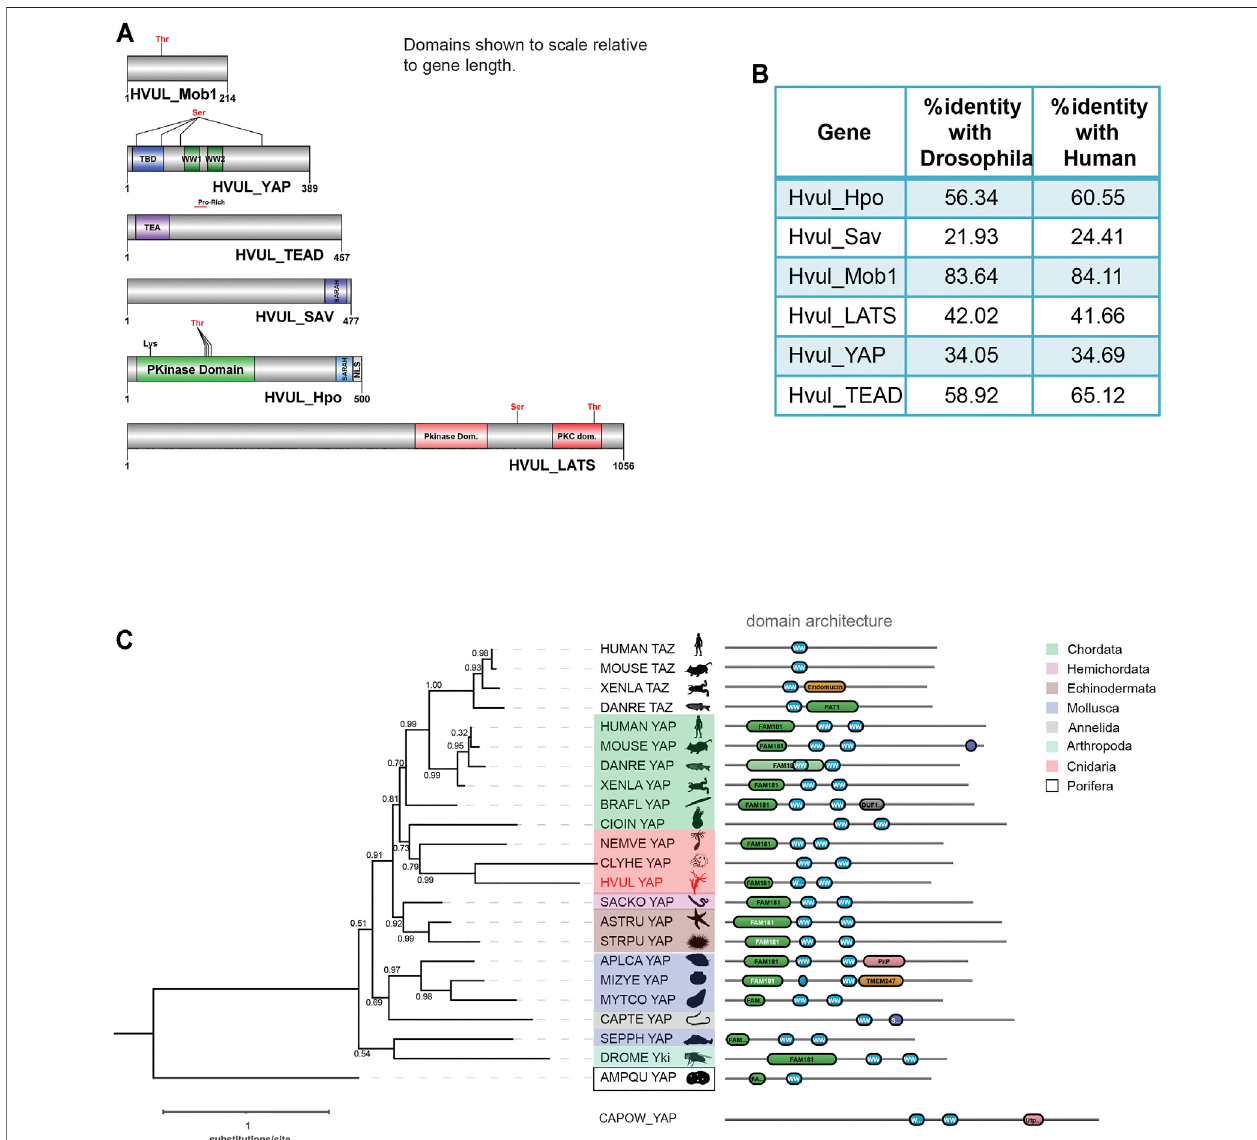
FIGURE 1 | Identi fi cation of Hippo pathway homologs in Hydra . (A) Domain architecture of the homologs as visualized using DOG 2.0. (B) Depicts the percent identity of Hydra homolog with Drosophila and Human. (C) Phylogenetic tree and domain organization of YAP homologs across the animal phyla. The phylogenetic analysis was carried out on NGphylogeny.fr webserver and the tree was generated using FastTree 2 method. Here, the phylogenetic tree was rooted at Amphimedon queenslandica YAP-likesequence (AMPQU).Domain organizationanalysis wascarried out using DoMosaics software.Branch support values aredisplayed at the branchingpoints.Differentphylaarehighlightedwithdistinctcolours. Hydra YAPhomologue( HVUL YAP)ishighlightedinredcolourfont.AUNIPROTstyleabbreviations for organism names are used. Sequence details are provided in the Supplementary Table S4